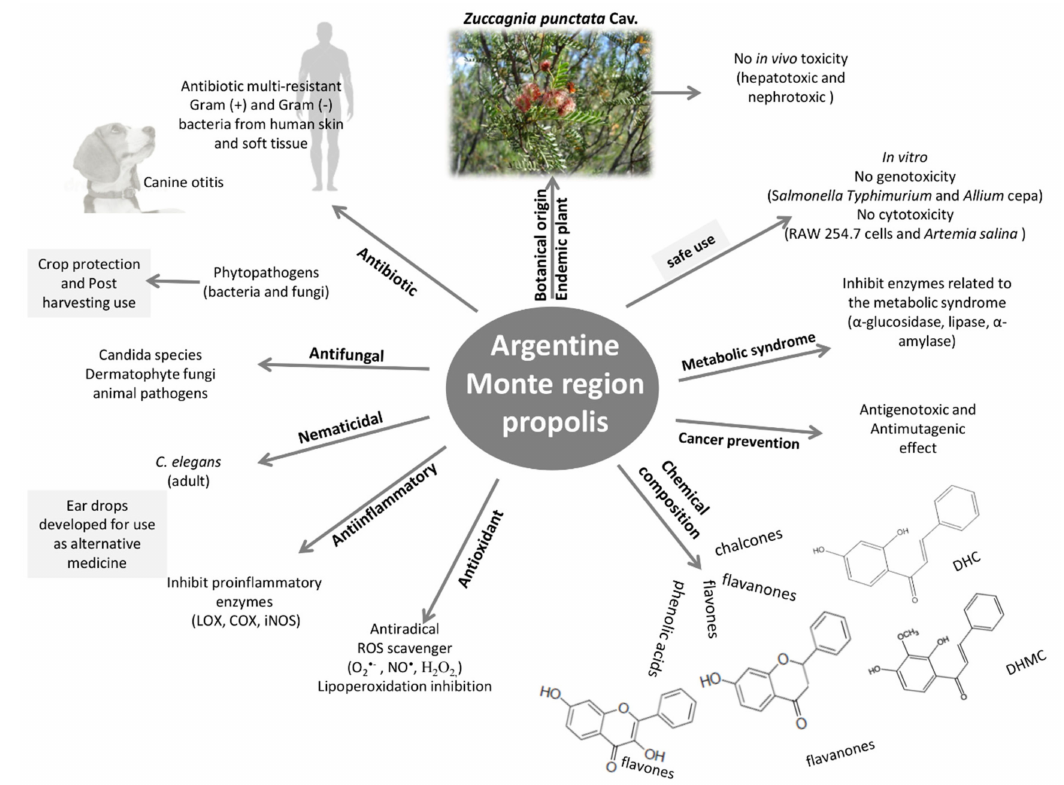
Figure 2. Functional properties of propolis from the Monte